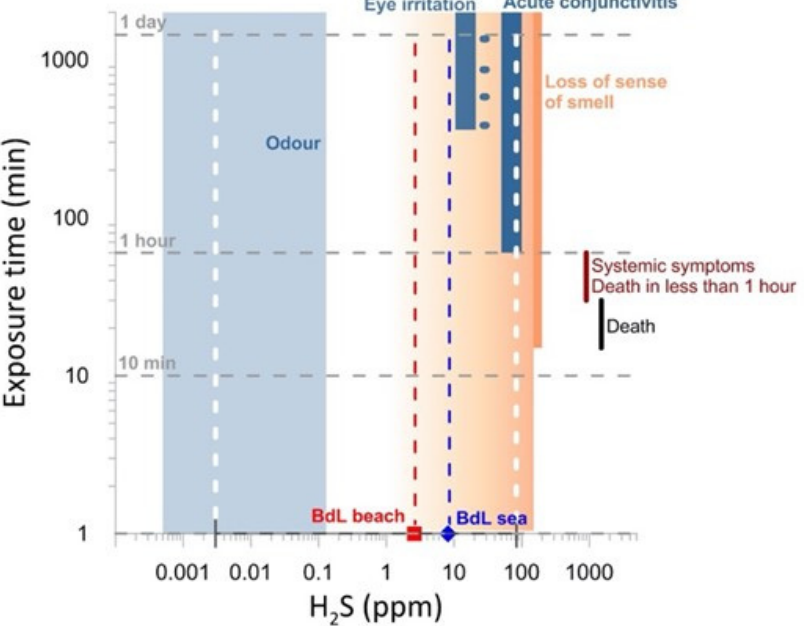
Figure 11. Atmospheric concentrations of H 2 S on the sea surface and on the beach of Baia di Levante area compared with associated human health risks (reference values available at http://www.inchem.org/documents/ehc/ehc/ehc019.htm). Points indicate the average concentrations measured during the surveys. Blue and red vertical dashed lines represent average values for BdL beach and BdL sea, respectively. White vertical dashed lines represent minimum and maximum values measured both at the BdL beach and BdL sea.